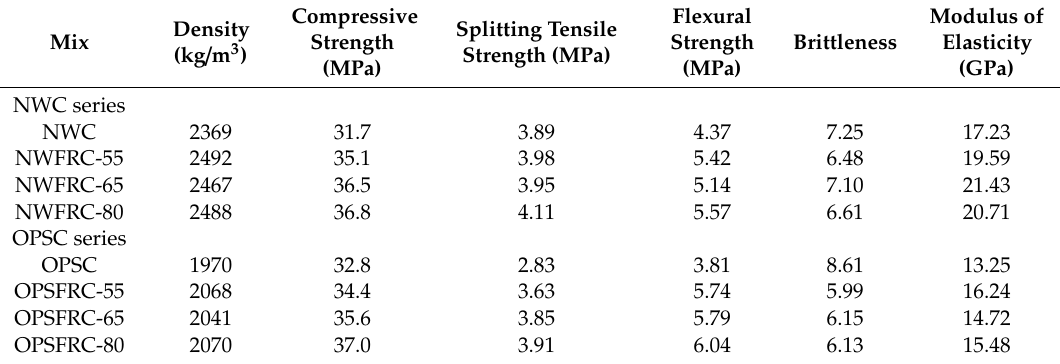
Table 3. Densities and mechanical properties [71], with copyright permission from